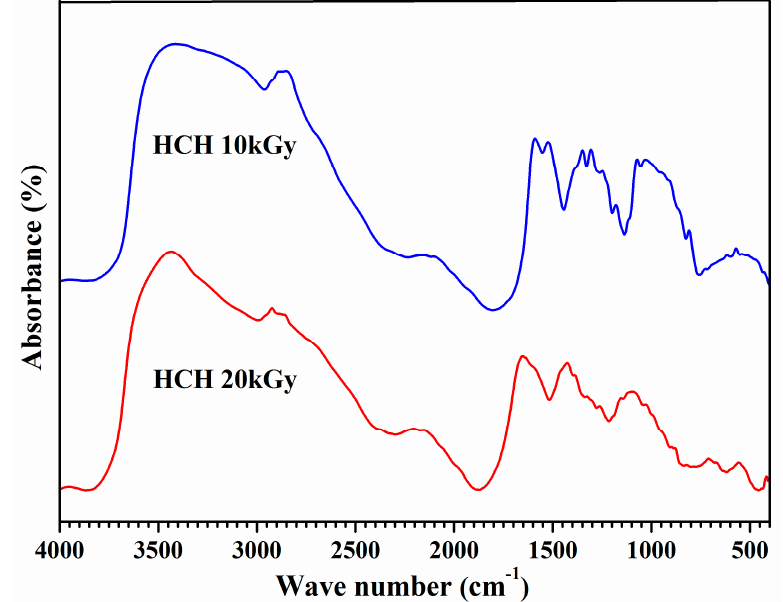
Figure 2. Fourier transfer infrared (FTIR) spectra of horseshoe crab chitosan (HCH) irradiated at 10 and 20 kGy.